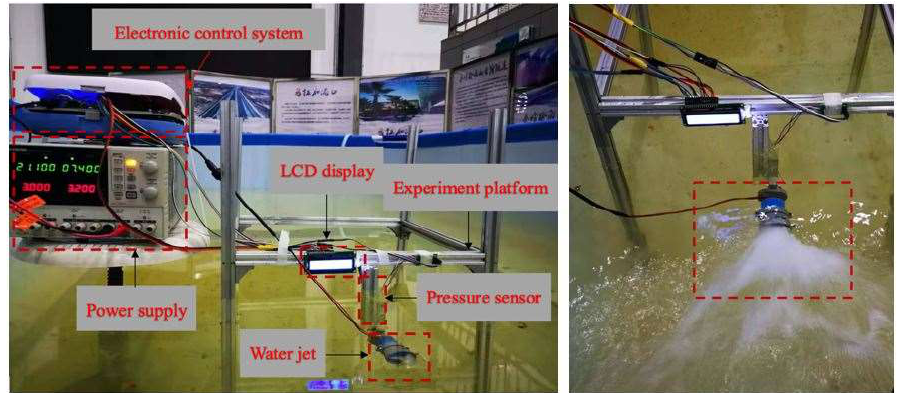
Figure 7. Experimental setup of the water-jet thruster.